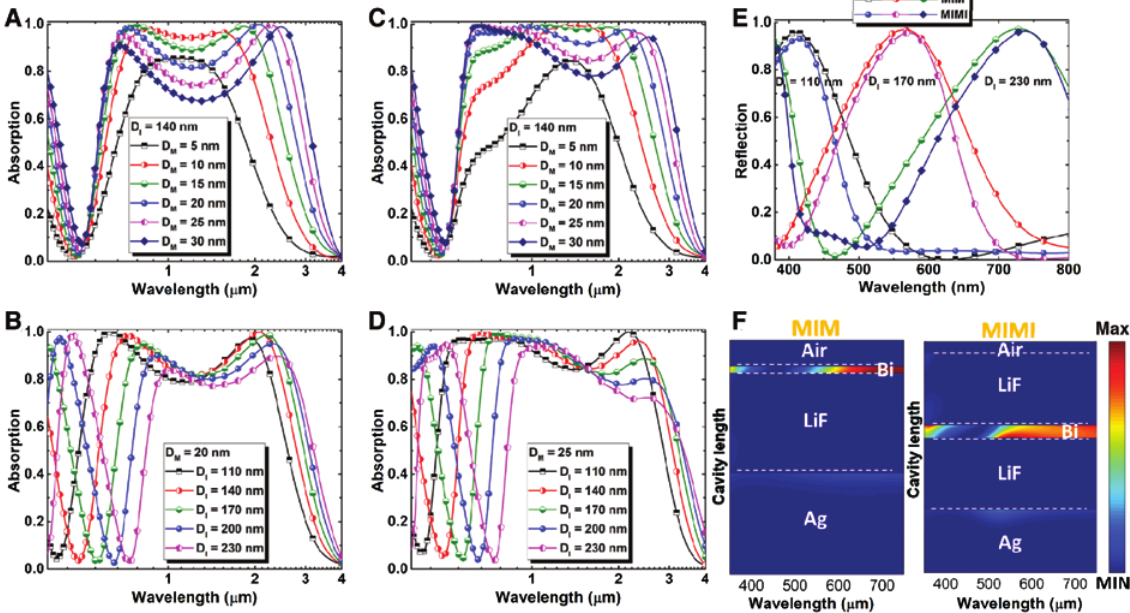
Figure 2: The parametric study on the cavity dimension to optimize light perfect absorption. The absorption spectra of the metal-insulator-metal (MIM) design for different (A) D cavity for different (C) D and (D) D values. (E) The reflection spectra of the MIM and MIMI designs in the visible frequency range for three M I different D values of 110 nm, 170 nm, and 230 nm. (F) The absorption contour plot across the cavity for MIM and MIMI architectures for the I = 110 case of D I